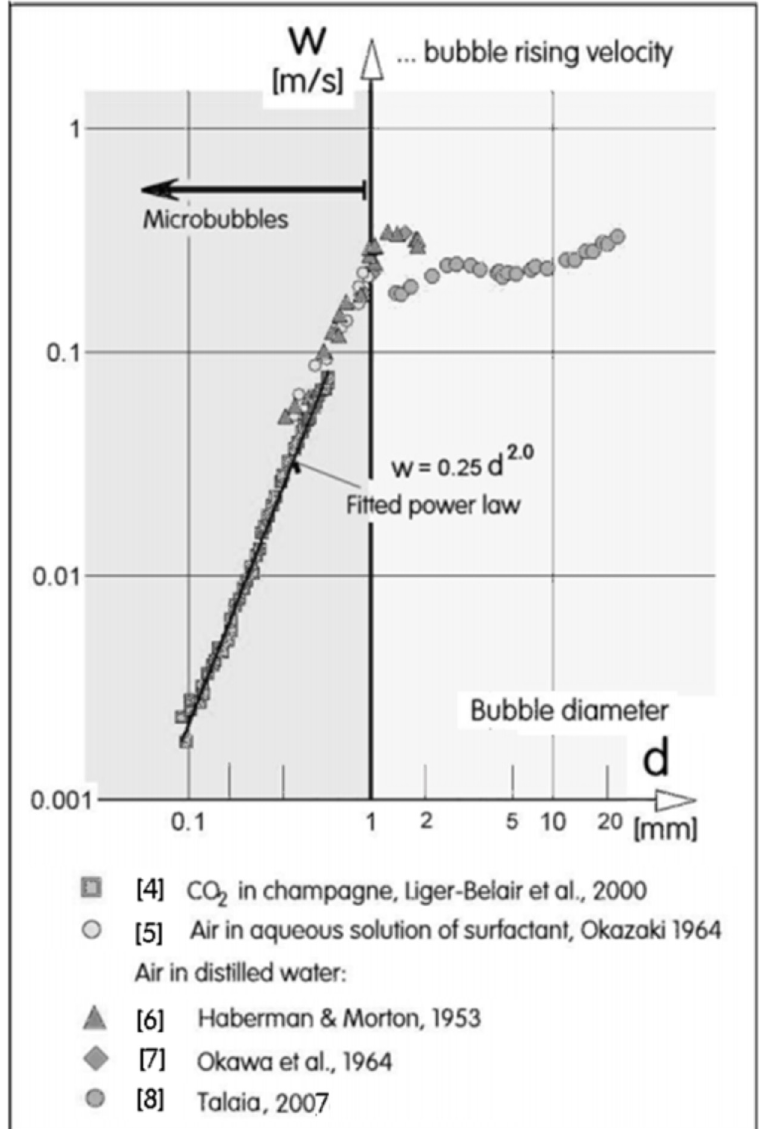
Figure 2. Terminal velocity of small bubbles rising in stationary liquid, from [9]. The velocity of microbubbles ( d < 1 mm) decreases rapidly with their decreasing diameter.